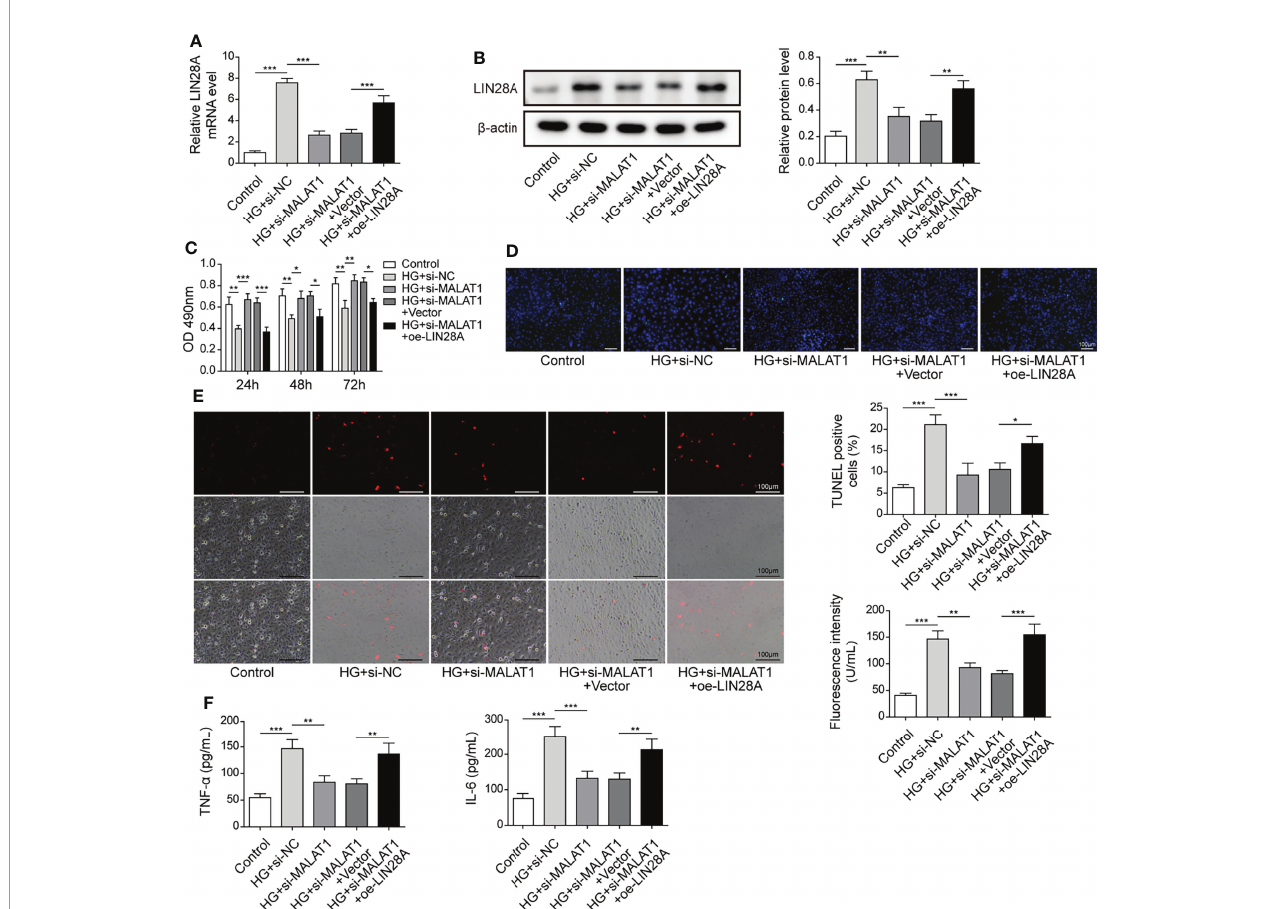
FIGURE 4 | MALAT1-mediated aggravation of HG-induced injury was dependent on LIN28A. HK-2 cells were transfected with si-NC, si-MALAT1, si-MALAT1 + vector or si-MALAT1 + oe-LIN28A and subsequently treated with HG for 48 h (A) qRT-PCR analysis of LIN28A (n=4). (B) Protein levels of LIN28A were assessed by western blotting (n=4). (C) Cell viability was examined by MTT assays (n=4). (D) TUNEL staining (TUNEL, green. Scale bar=100 µM) were examined. (E) Cellular ROS levels were examined by a fl uorometric ROS sensor (red, n=4. Scale bar=100 µM). (F) Secretion of TNF- a and IL-6 into culture supernatants (n=4). * P < 0.05, ** P < 0.01 and *** P <